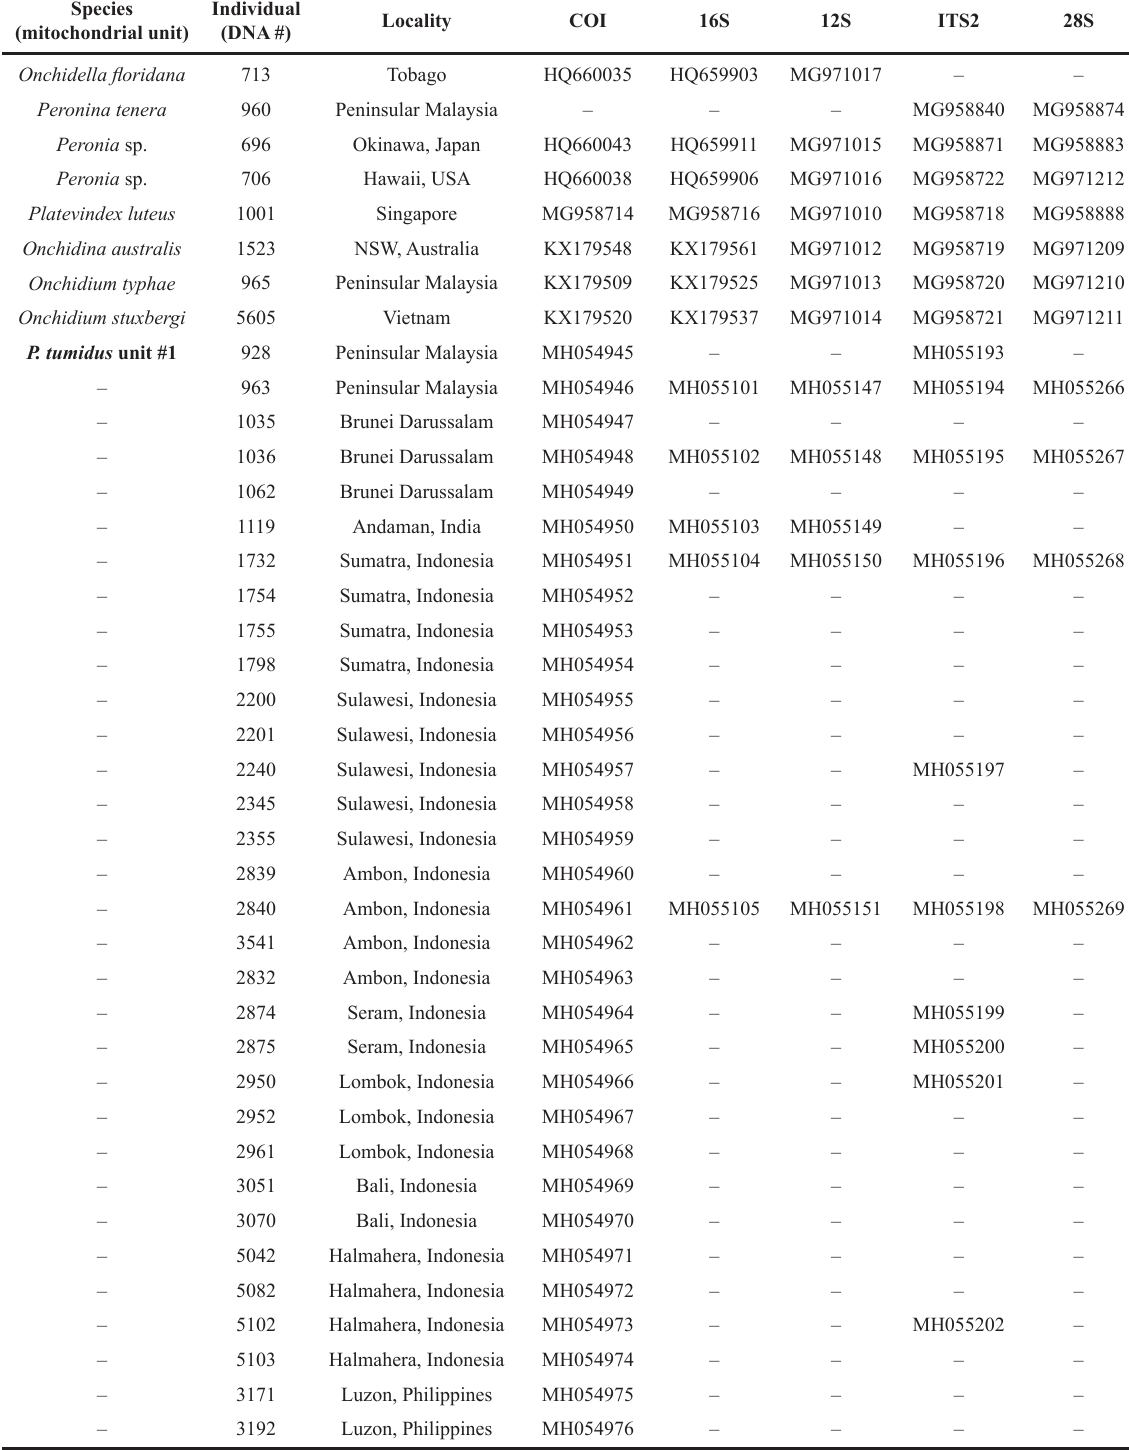
Table 1. (continued on next three pages) GenBank accession numbers for COI, 16S, 12S, ITS2 and 28S DNA sequences. All sequences are new, except the COI and 16S sequences of six of the seven outgroups (Dayrat et al. 2011a, 2016; Dayrat & Goulding 2017) and three COI sequences of P. tumidus (unit #1) from mainland China found in GenBank (misidentified as Paraoncidium reevesii (J.E. Gray, 1850) in Sun et al.